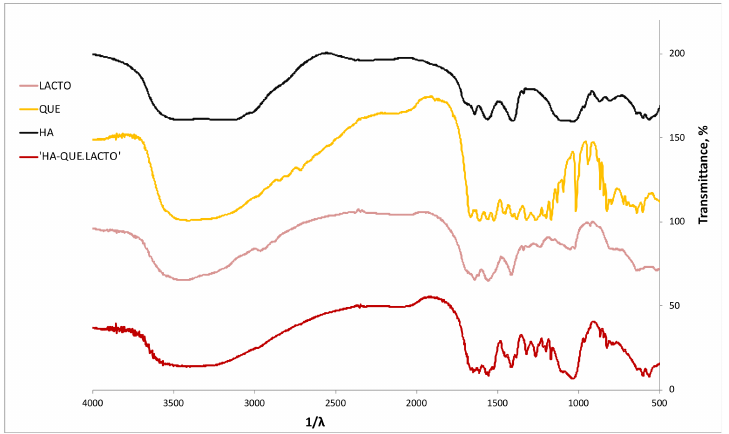
Figure 1. FT-IR spectra of HA, LACTO, QUE and HA/LACTO-QUE